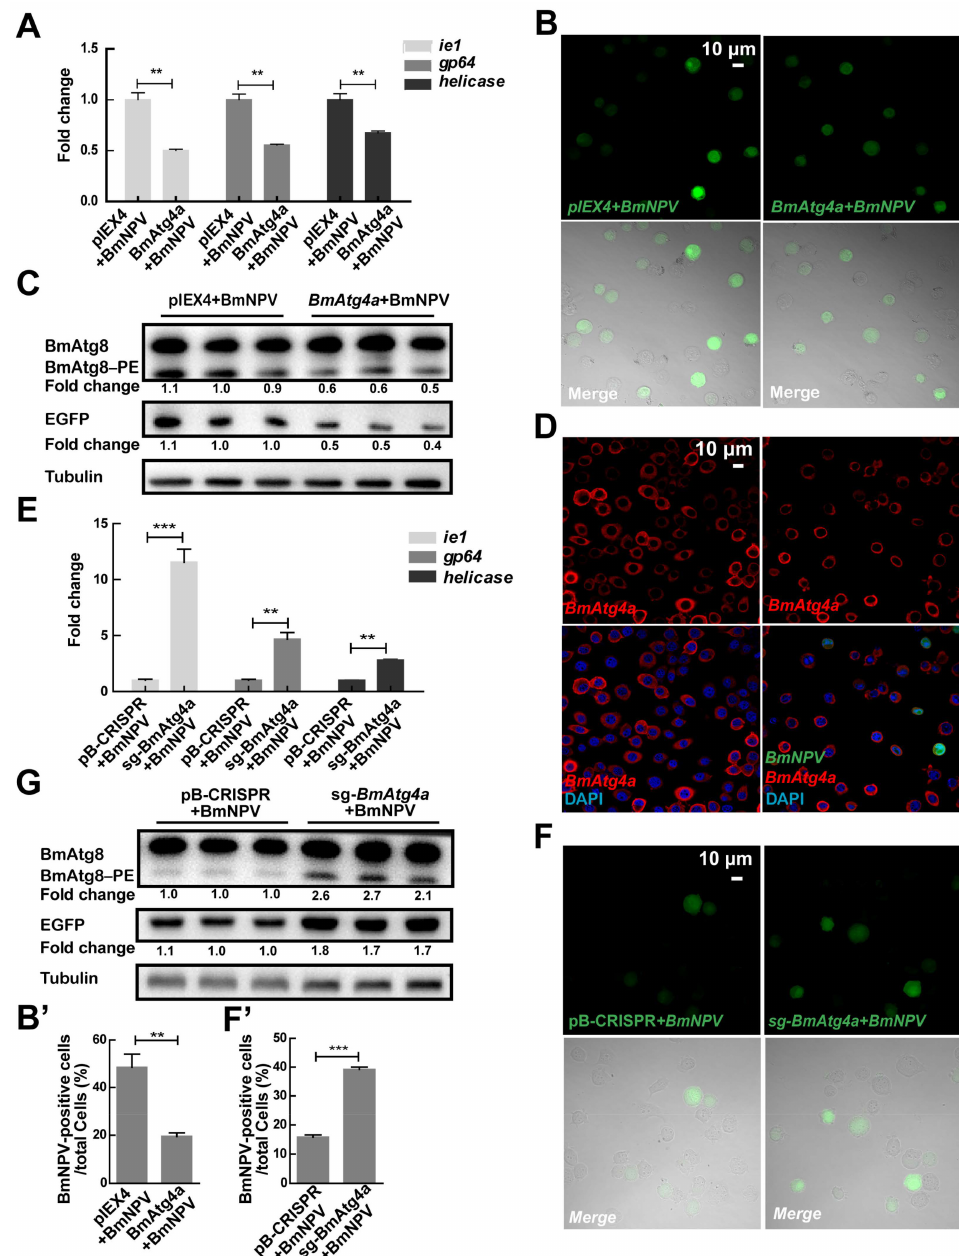
Figure 3. Effect of BmAtg4a on the proliferation of BmNPV in BmN cells. ( A ) The copies of BmNPV genes, including ie1 , gp64 , and helicase, were detected by qPCR after overexpression of BmAtg4a for 48 h, followed by BmNPV infection for a further 48 h. ( B ) The green fluorescence of BmNPV-EGFP was observed after the overexpression of BmAtg4a . ( B’ ) Quantification of the EGFP-positive cells in ( B ). ( C ) The protein levels of BmAtg8/BmAtg8–PE and the viral EGFP detected by WB after overexpres- sion of BmAtg4a . Fold change means the variation of BmAtg8–PE and EGFP protein levels in ( C ). ( D ) IF staining of the overexpressed BmAtg4a after BmNPV infection for 48 h. ( E ) The gene copies of ie1 , gp64 , and helicase were detected by qPCR after the knockout of BmAtg4a . ( F ) The green fluorescence of BmNPV-EGFP was observed after the knockout of BmAtg4a . ( F’ ) Quantification of EGFP-positive cells in ( F ). ( G ) The protein levels of BmAtg8/BmAtg8–PE and the virus-expressed EGFP were detected by WB after knockout of BmAtg4a . Fold change indicates the variation of BmAtg8–PE and EGFP protein levels in ( G ). ** p < 0.01, *** p <